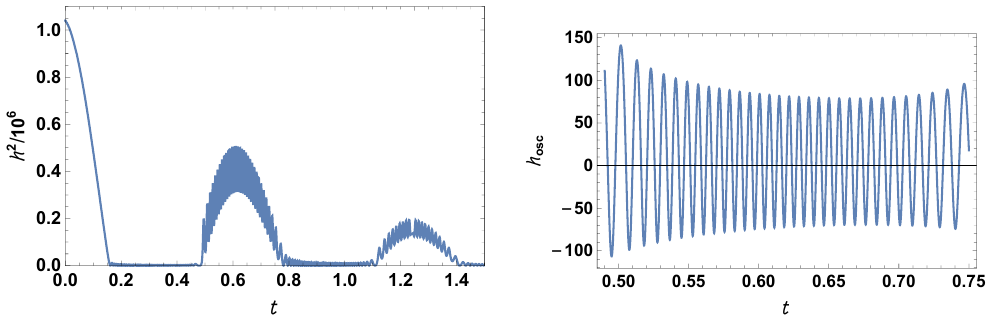
Figure 1 . Left: h 2 as a function of t . Right: h osc as a function of t in the symmetry breaking phase. We (cid:12)x M = 1020 H; m (cid:31) = 10 H; m h = 2 H; (cid:21) =